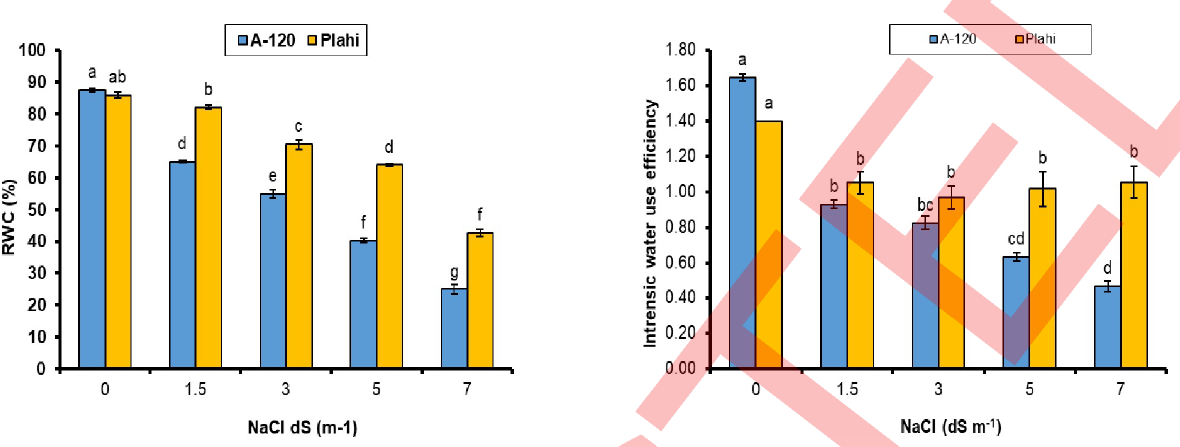
Fig 2. Effect of NaCl stress on relative water content and water use efficiency of two chili genotypes.